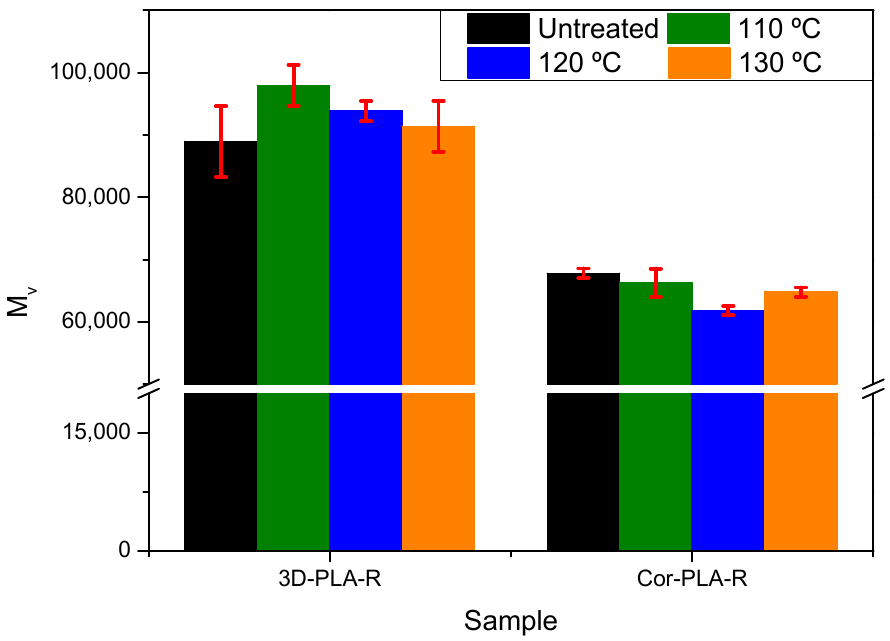
Figure 12. Viscosimetric average molecular weight of the samples after SSP.